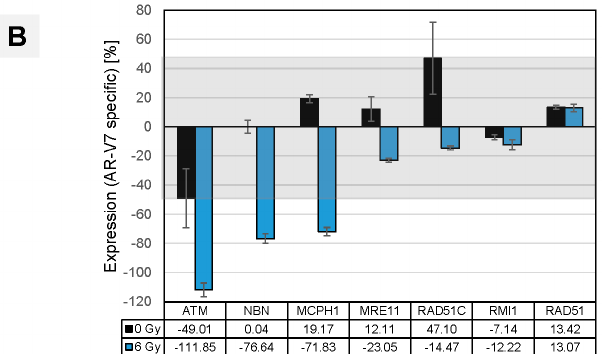
Figure 10. ( A ) Impact of AR splice variants in clinical CRPC via the validation of deregulated DNA